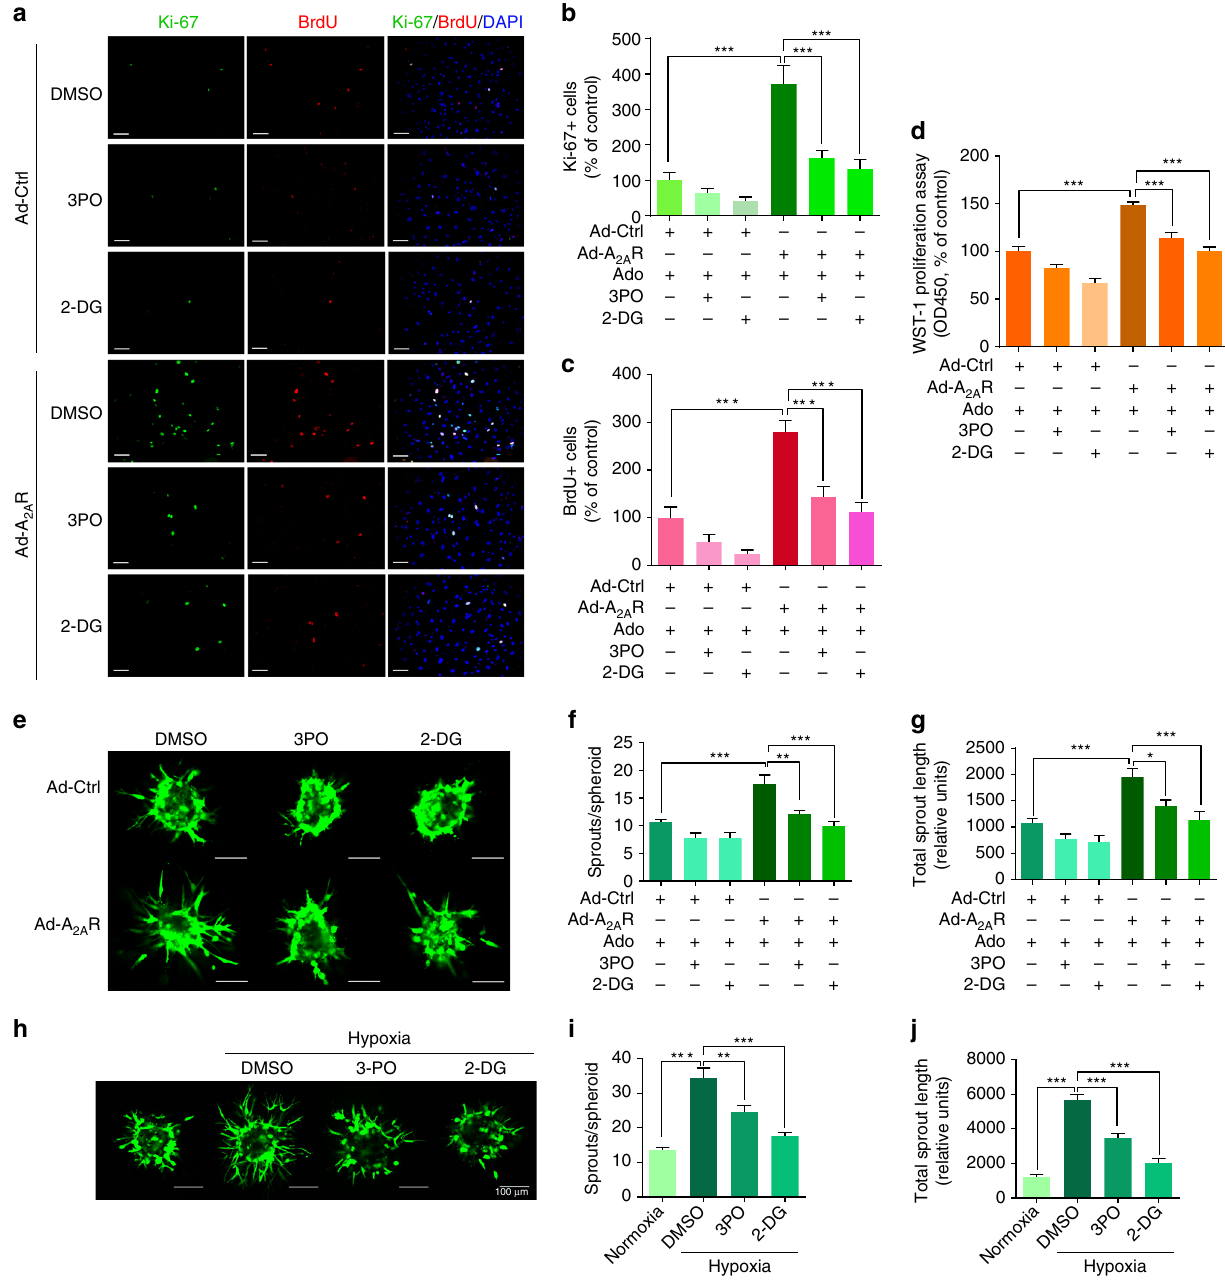
Fig. 6 Glycolysis is involved in ADORA2A activation-mediated HRMEC proliferation and sprouting. a – g Results of Ki-67 and BrdU staining a – c , WST-1 cell proliferation assay d and EC spheroid sprouting assay e – g in HRMECs. HRMECs were infected with Ad-Ctrl or Ad-A 2A R adenoviruses, and then treated with adenosine in the presence or absence of two different glycolytic inhibitors (3PO, 10 μ M, and 2-DG, 5 mM). n = 6. * P < 0.05; ** P < 0.01; *** P < 0.001. Scale bars : 50 μ m for a ; Scale bars : 100 μ m for e . h – j HRMECs were cultured as 3D multicellular spheroids in the presence or absence of 3PO or 2DG. Representative images of spheroidal sprouting after culturing for 24 h in collagen matrix under hypoxia (0.5% O 2 ) or normoxia (21% O 2 ) h . Morphometric quanti fi cation of spheroid sprouting by calculating the number of sprouts per spheroid i and total sprout length j . n = 10 per group ( n is number of spheroids quanti fi ed). * P < 0.05, ** P < 0.01; *** P < 0.001. Scale bars : 100 μ m. Data are represented as means ± s.e.m. Statistical signi fi cance was determined by one- way ANOVA followed by Bonferroni